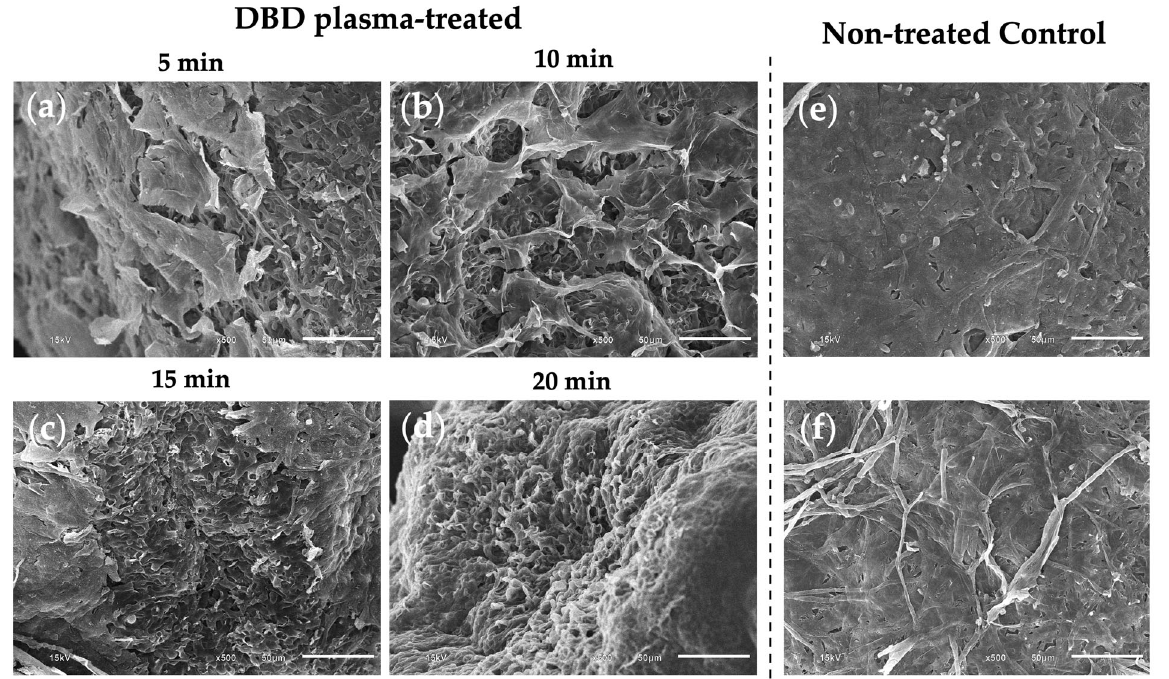
Figure 4. Scanning electron micrographs of sclerotia of Athelia rolfsii ( a – d ) after exposure to DBD plasma for 5, 10, 15, and 20 min compared with the non ‐ treated control ( e , f ). Sclerotia exposed to DBD plasma showed lacerated and sunken surfaces, whereas sclerotia from the non ‐ treated control showed regular surfaces.